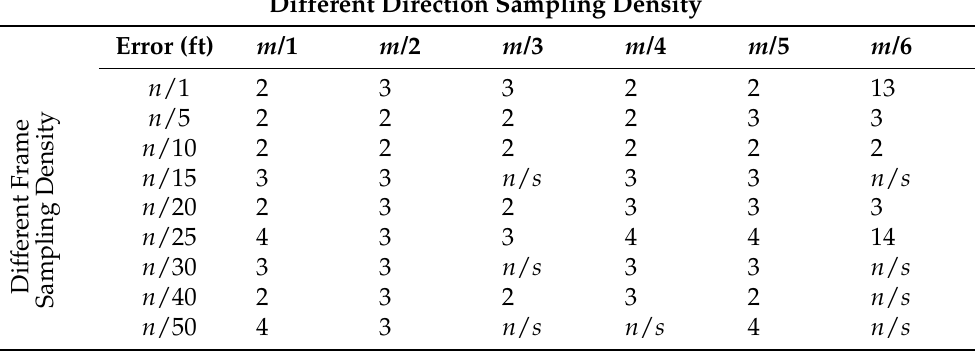
Table 4. Mean estimated direction errors ( ◦ ) of 17 testing locations under different combination of frame downsampling rate α and direction downsampling rate β . n / s indicates that directions at some testing locations cannot be